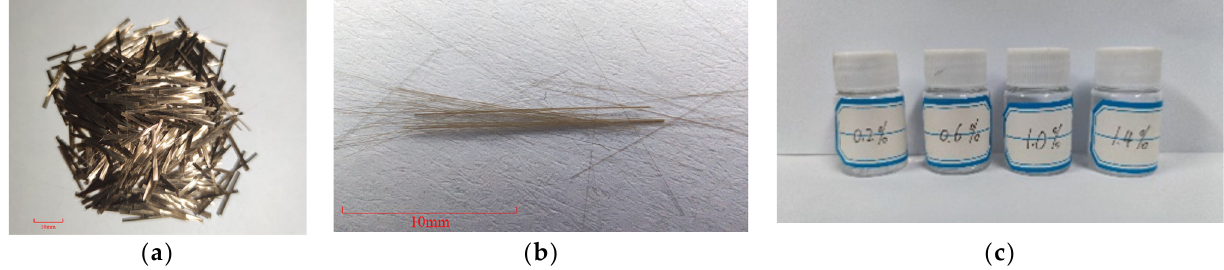
Figure 1. Basalt fibers and KH550 used in the study: ( a ) basalt fiber; ( b ) basalt fiber 5×; ( c ) KH550.